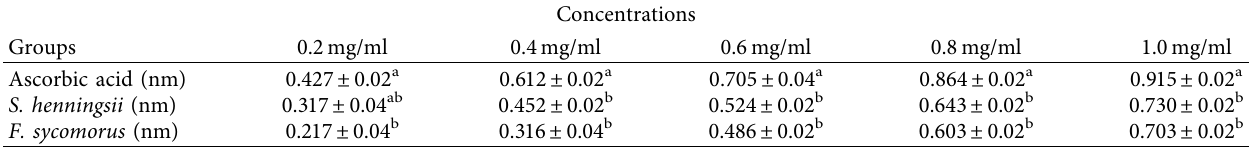
Table 7: In vitro ferric reducing power activities of the DCM extracts of S. henningsii and F. sycomorus